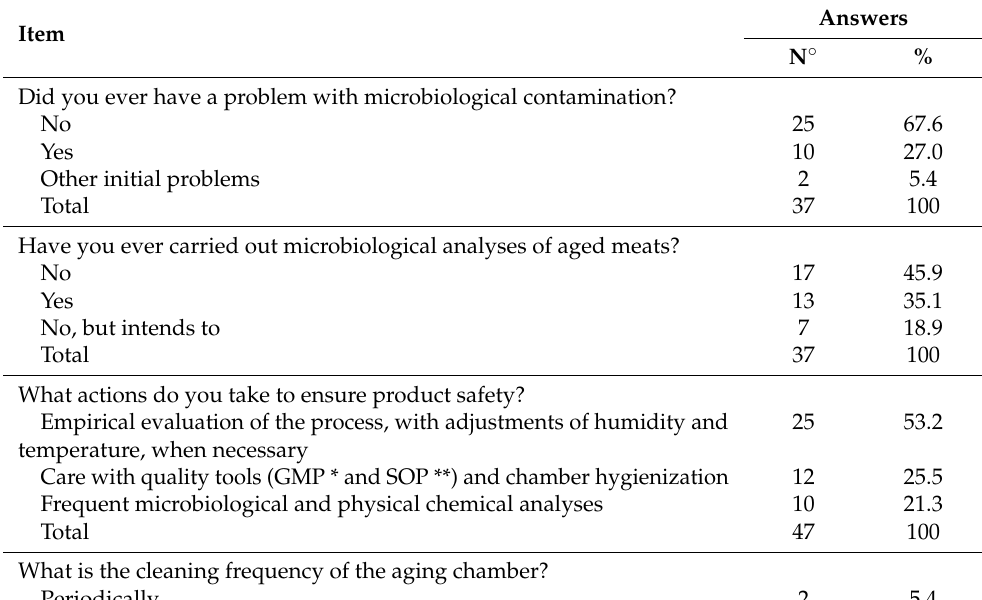
Table 8. Safety of dry-aged meat production in